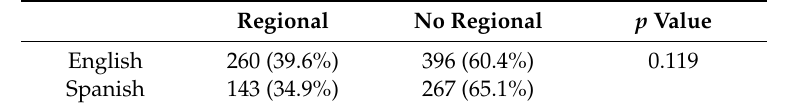
Table 2. Subgroup analysis, and use of regional anesthesia for Latino / a families by primary language.